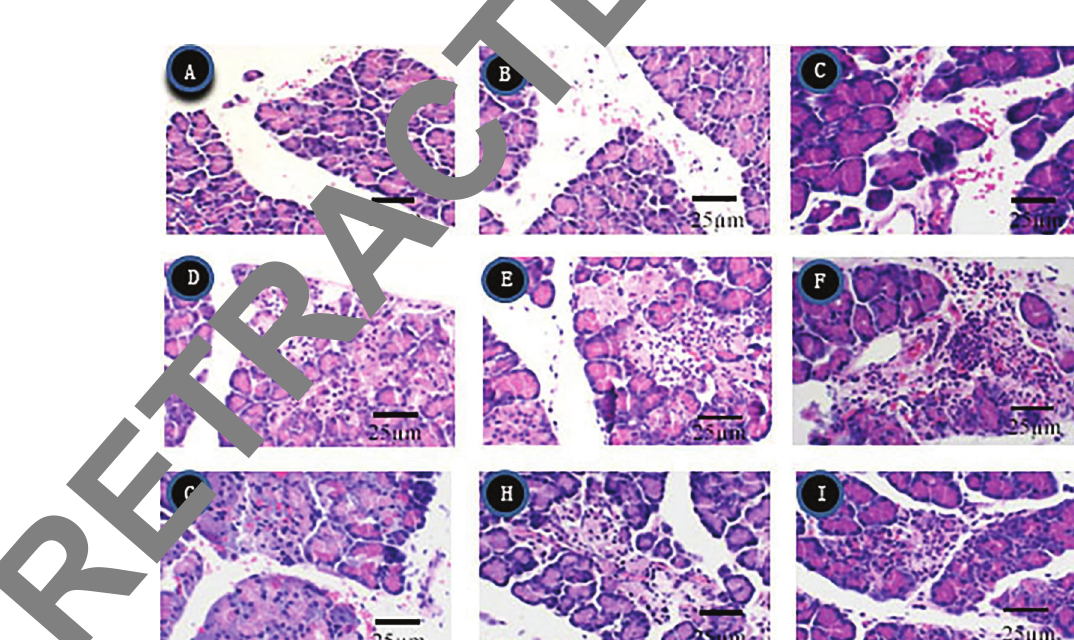
Braz J Med Biol Res | doi: